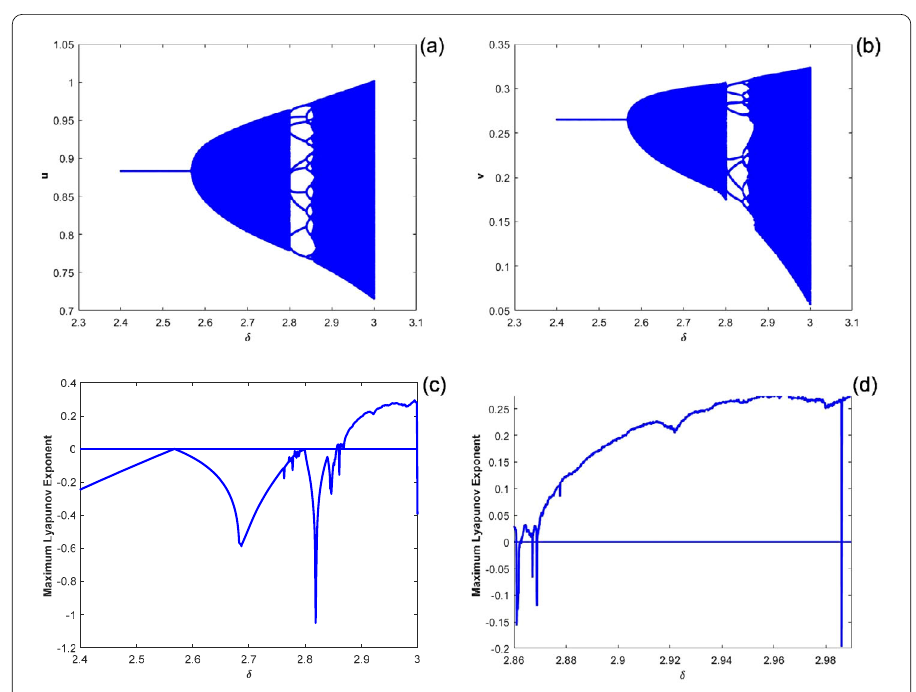
Figure 3 ( a ) Hopf bifurcation diagram of map (3) in the ( δ , u ) plane with initial value (0.8933954475,0.2750186342). ( b ) Hopf bifurcation diagram of map (3) in the ( δ , v ) plane. ( c ) Maximum Lyapunov exponents corresponding to Figs. 3(a), (b). ( d ) Local amplification diagram of ( a ) for δ ∈ [2.75,2.9]